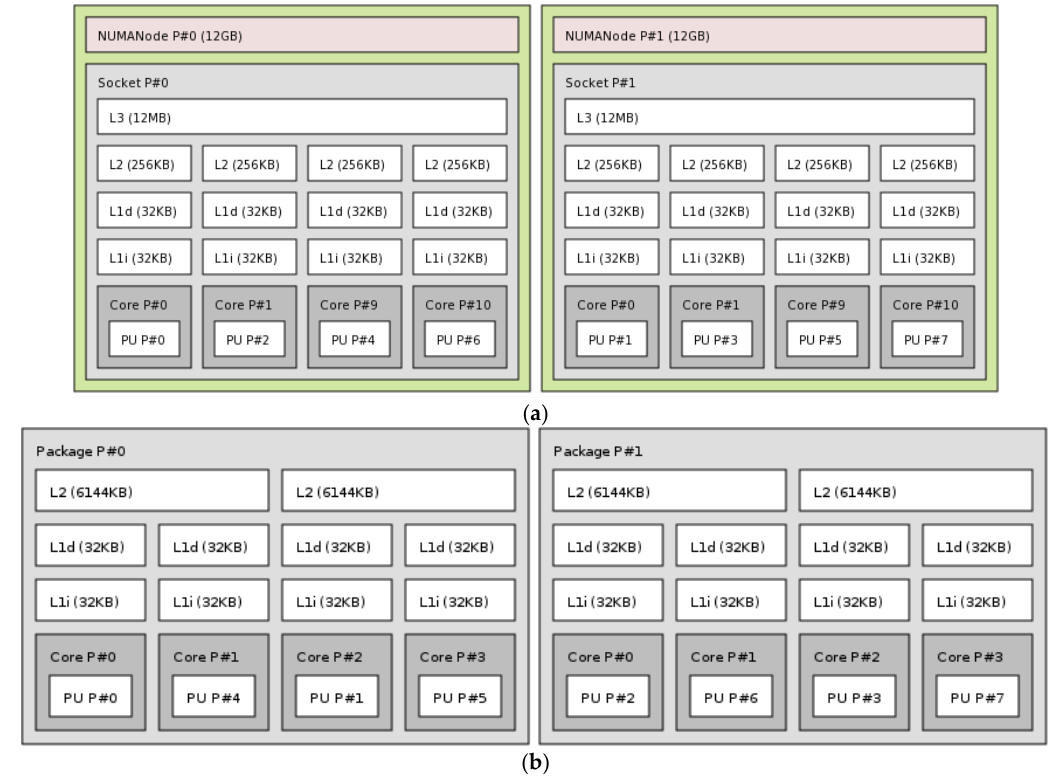
Figure 3. Hierarchical structure of the computing nodes of clusters Oak and Jet. ( a ) Computer node of cluster Oak; ( b ) Computer node of cluster Jet.